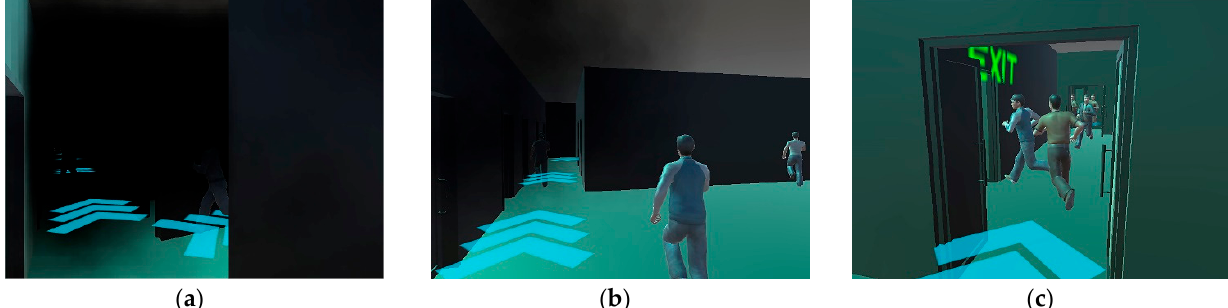
Figure 12. Evacuation drill process with signs. ( a ) Start evacuation; ( b ) In evacuation; ( c ) Evacuation exit.